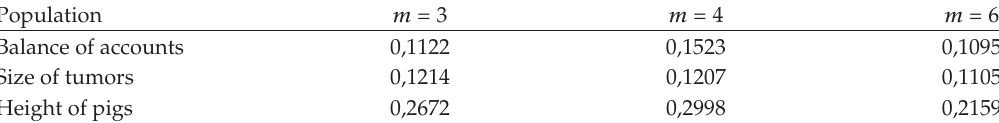
Table 1: Gain in accuracy due to the use of RSS in three populations.